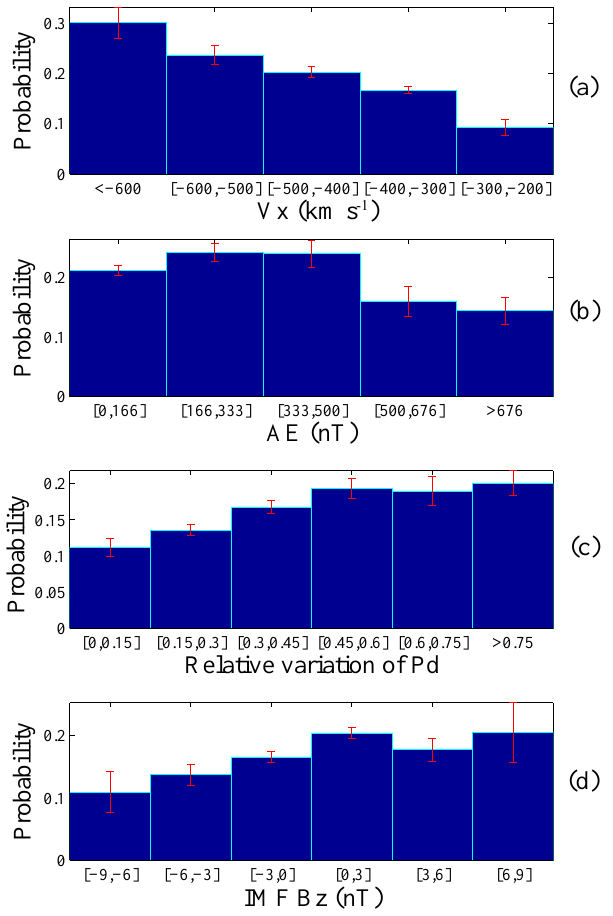
Figure 8. The occurrence probability of waves versus (a) solar wind velocity V x , (b) AE index, (c) relative variation of Pd, and (d) IMF B z